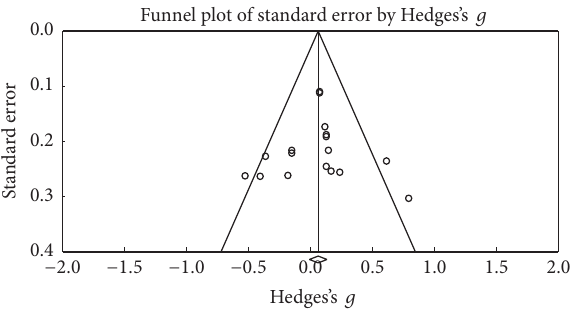
Figure 4: Funnel plot for standard error in publications of cognitive flexibility